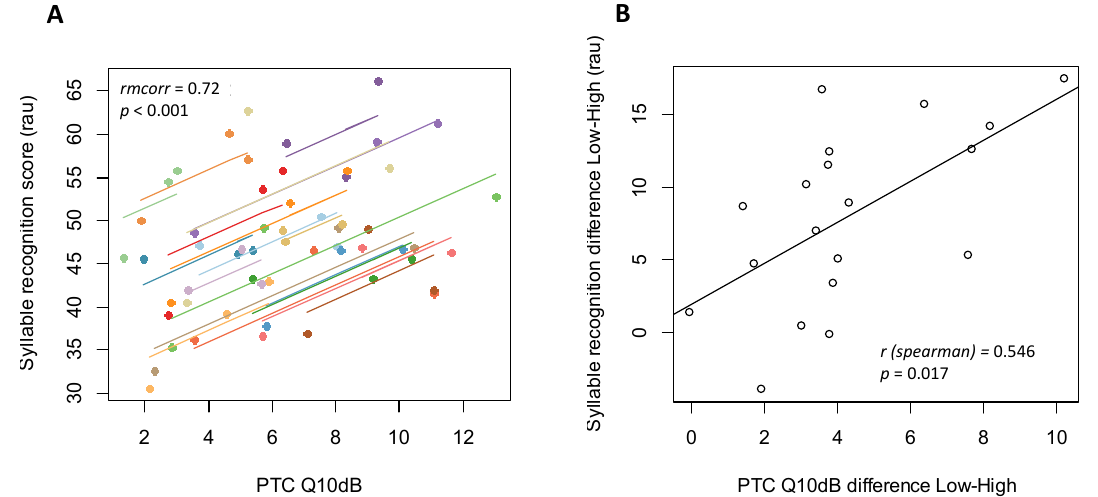
Figure 6. Average syllable recognition scores (in rau) function of Q10dB ( A ) Repeated measures correlation (rmcorr). Measures from the same participant are given the same color, with corresponding lines to show the rmcorr. There are 3 dots per participants, one for each level of spread of excitation. ( B ) Average syllable recognition difference function of Q10dB difference between “Low” and “High” spread of excitation simulation. Each dot represents one subject.